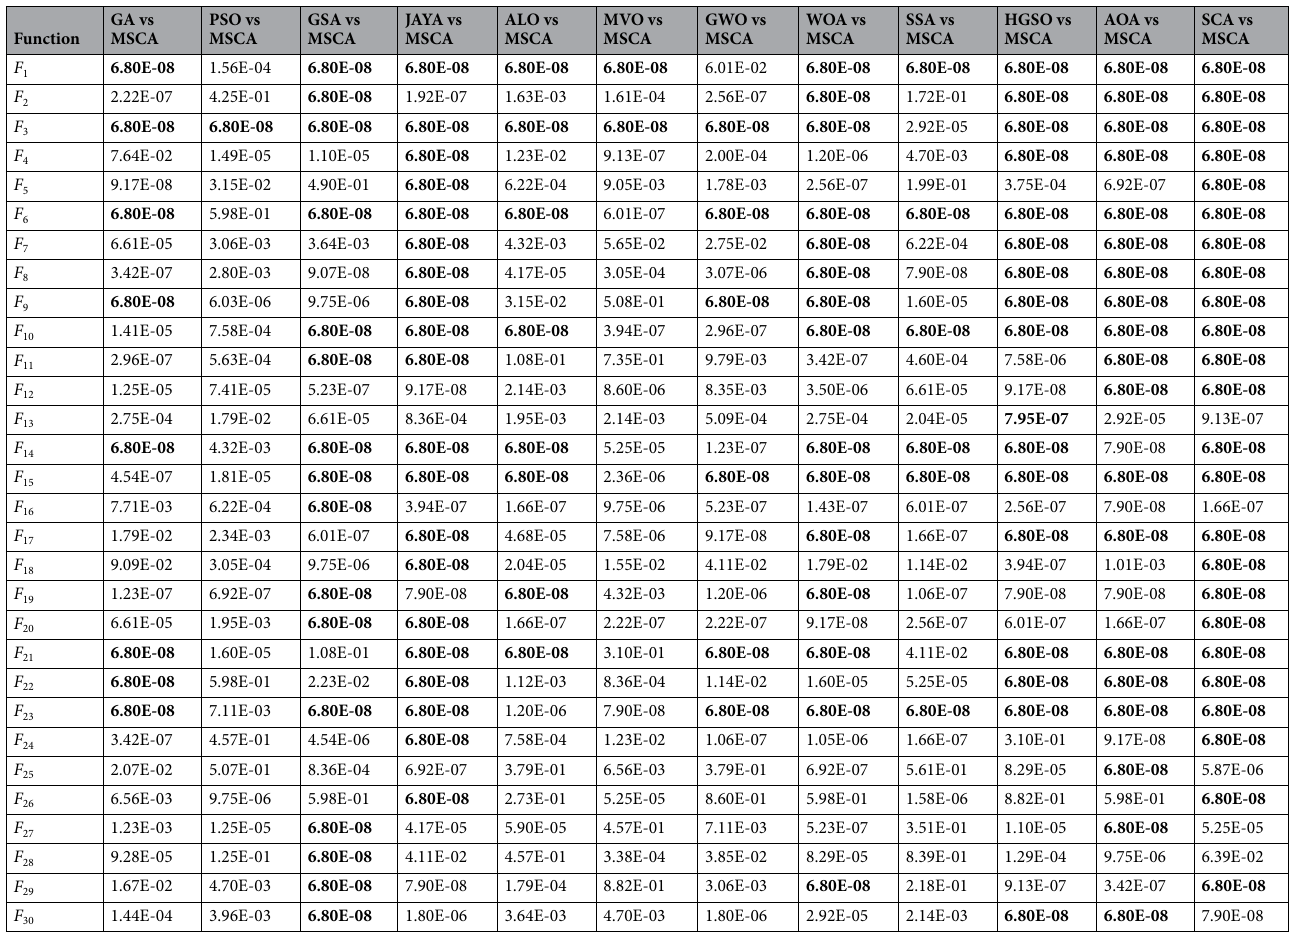
Table 8. Wilcoxon ranksum test on CEC17 test suit at 5% level of significance. Significant values are in